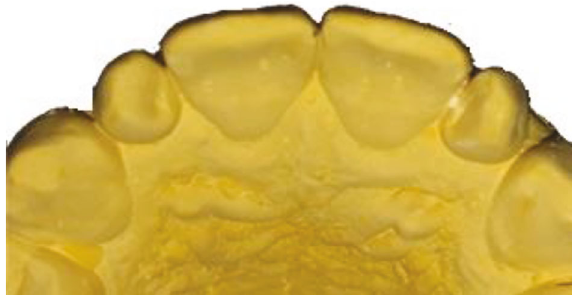
Figure 2: Rotation of both lateral incisors on diagnostic cast.